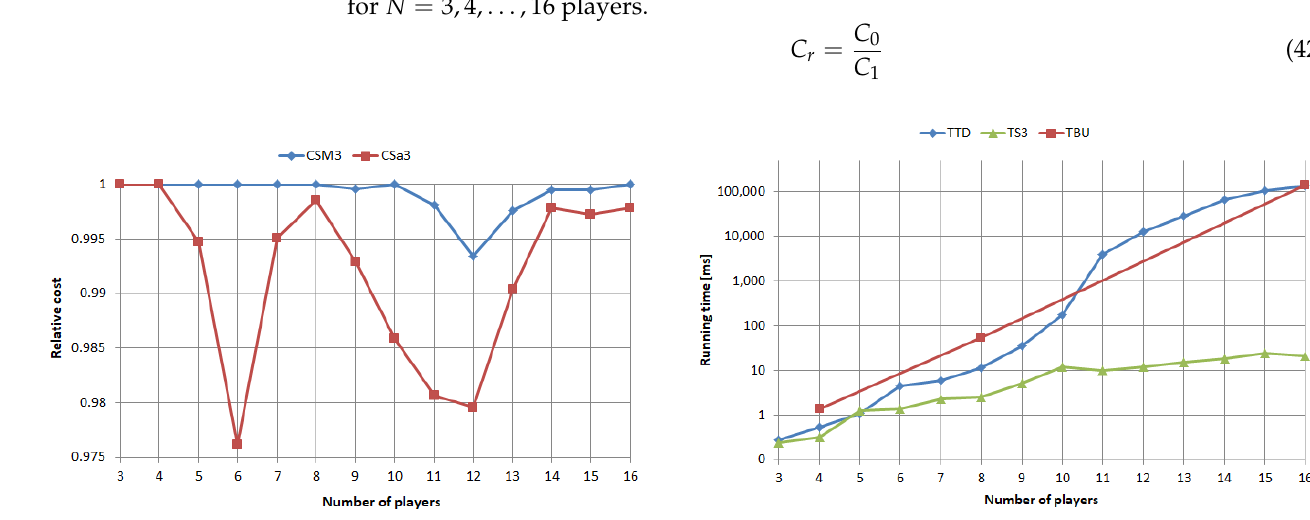
Figure 7. Comparing costs and running times of our implemented